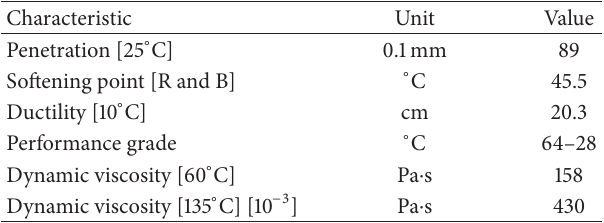
Table 1: Physical properties of the base bitumen.